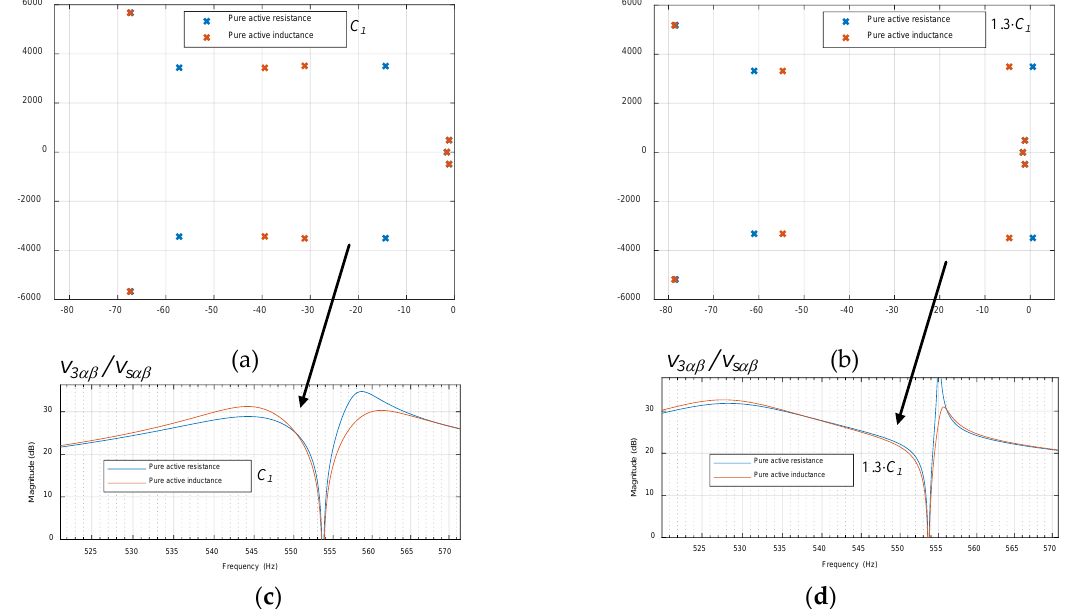
Figure 16. Pole plots and Bode plots of the voltage at the Pcc when the C 1 impedance of grid changes and pure active resistance ( R v 1 = 1.512 k Ω ) and pure active inductance ( L v 1 = − 437 mH, which is − 1.51 k Ω at 550 Hz) are programmed at the ACISEF at 550 Hz. ( a ) Pole plots with C 1 at the initially programmed value, ( b ) pole plots with the AC impedance changed to 1.3· C 1 , ( c ) Bode plot of v 3 αβ ( s )/ v s αβ ( s ) with C 1 at the initially programmed value, ( d ) Bode plot of v 3 αβ ( s )/ v s αβ ( s ) with the AC impedance changed to 1.3· C 1 .